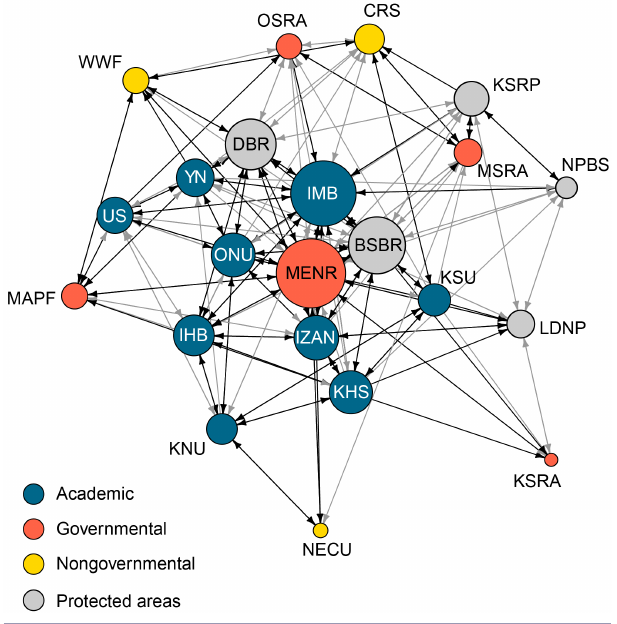
Fig. 2 . Sociogram of the information-transferring network of stakeholder organizations involved in Pontocaspian biodiversity conservation and planning. Nodes represent organizations (see Table 1 for full names). The size of the nodes corresponds to the node strength. Arrows represent relationships between the nodes and show the direction of relevant information transfer. Black arrows (ties with value ≥ 3) represent strong relationships; gray arrows (ties with value < 3) represent weak